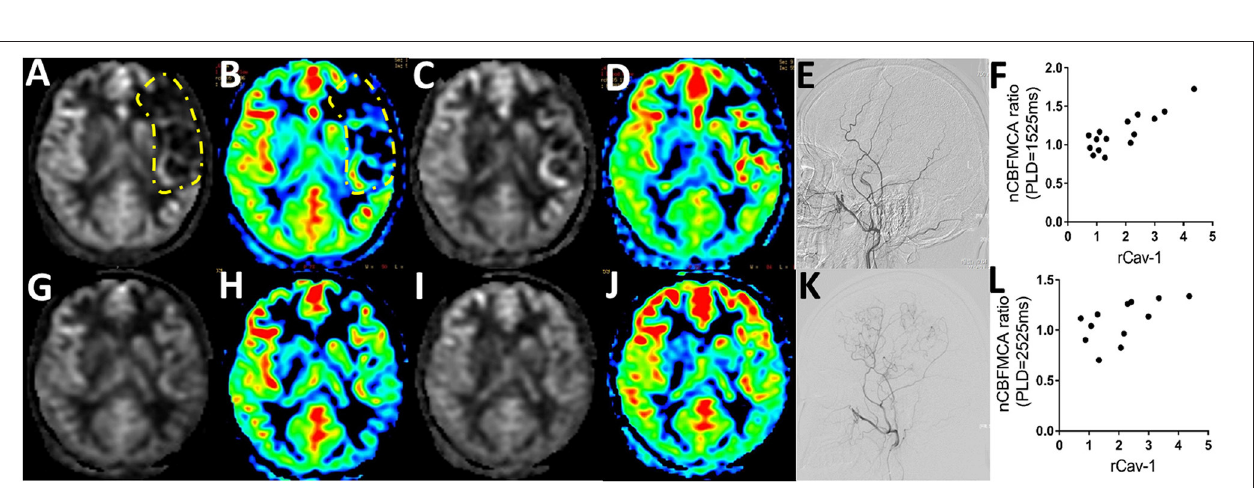
FIGURE 3 | Serum Cav-1 was associated with cerebral blood flow (CBF) determined by arterial spin labeling MRI (ASL-MRI). (A) 24-year-old female patient was hospitalized for right hand numbness and diagnosed as MMD. The raw and color preoperative CBF maps by regular postlabeling delay (PLD) (A,B) and long PLD pseudocontinuous ASL (pCASL) imaging (C,D) demonstrated the hypoperfusion of middle cerebral artery (MCA) territory (circled by yellow lines). The CBF improved obviously in 6 months postoperative pCASL scanning with regular PLD (G,H) and long PLD (I,J) . The collaterals from the left external carotid artery before and after bypass surgery were shown in (E,K) by DSA. The rCav-1 had a strong positive relationship with the nCBF MCA ratio in both the regular ( r = 0.8615, p < 0.0001, (F) ) and long PLD ( r = 0.5915, p = 0.0428, (L) ) by Spearman analysis. nCBF MCA ratio, postoperative/preoperative nCBF MCA ; nCBF MCA , CBF of MCA territory/CBF of ipsilateral cerebellum; rCav-1, postoperative/preoperative Cav-1.